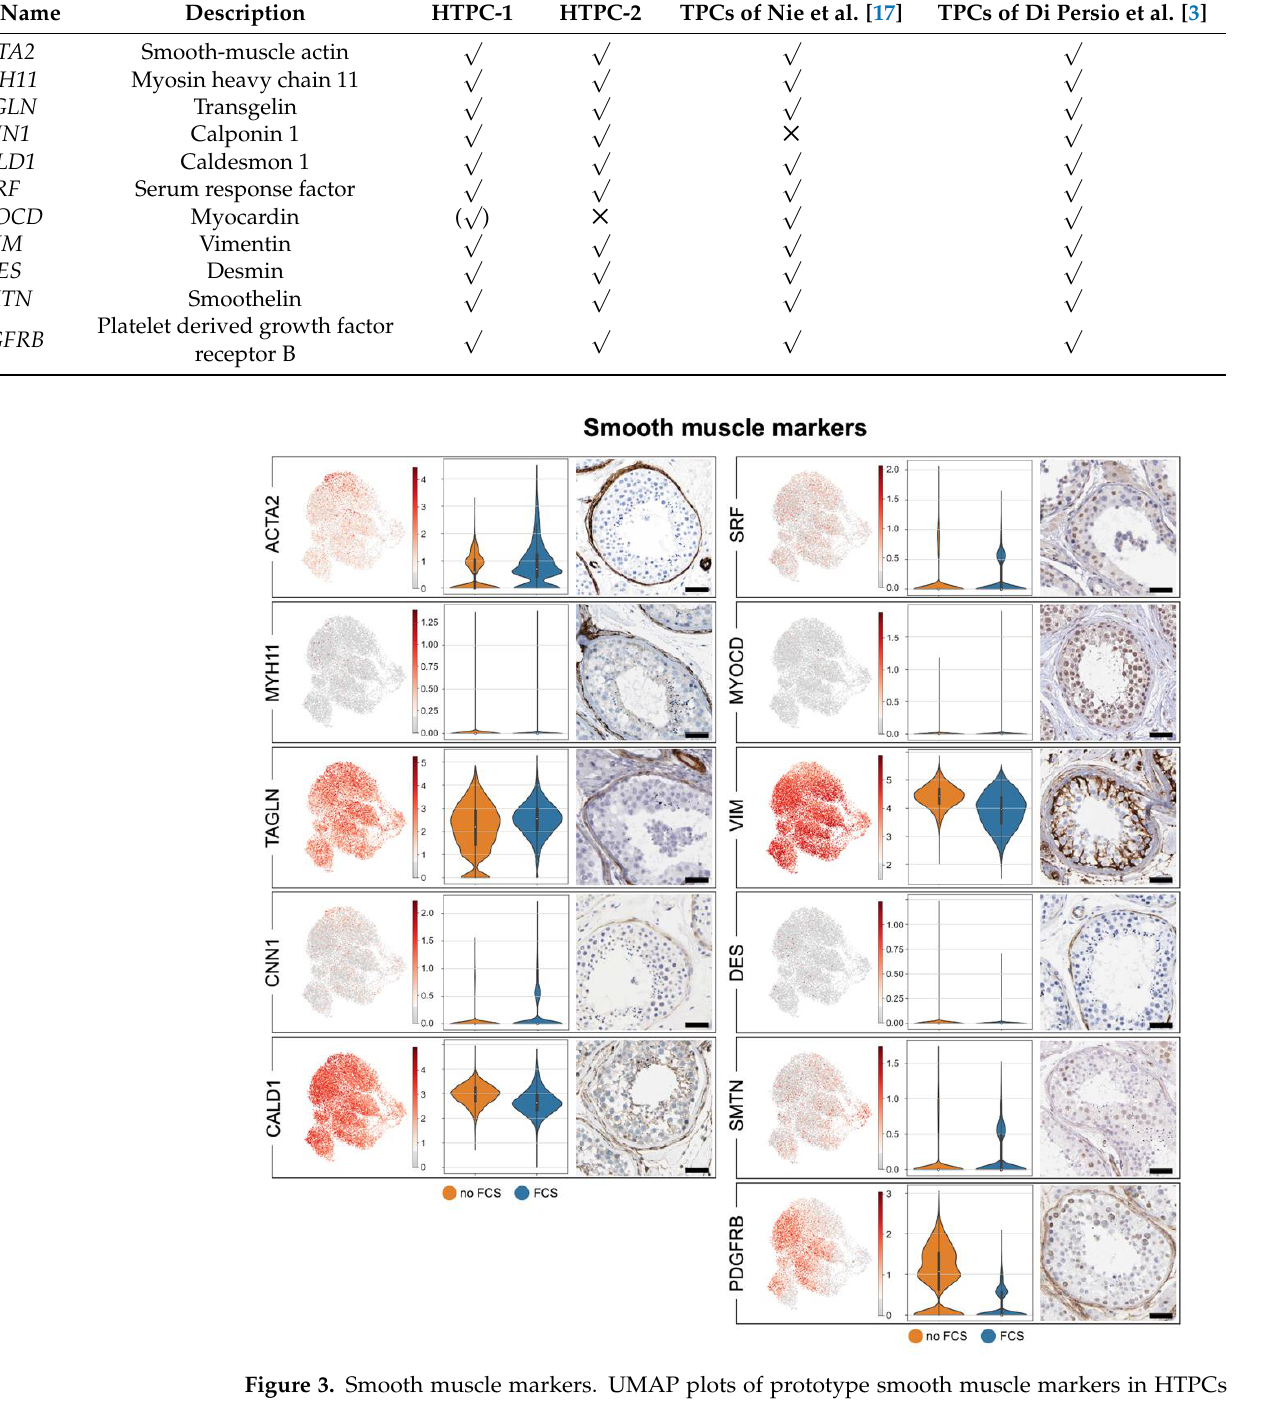
√ indicates expression; (cid:53) indicates absence;